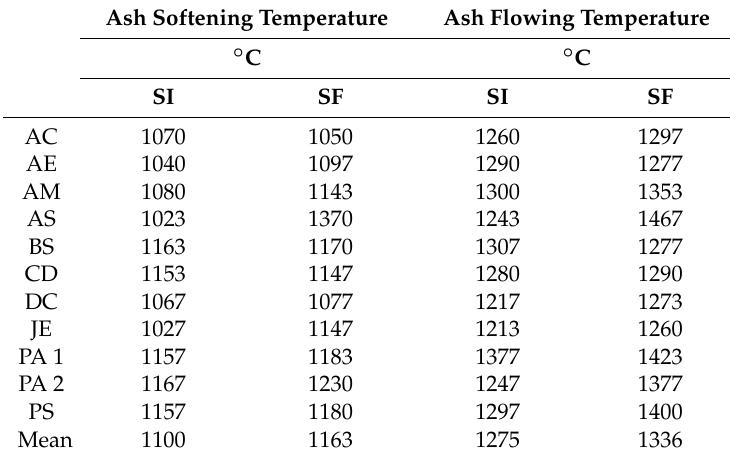
Table 4. Mean ash softening and flow temperature for silage (SI) and solid fuel (SF). Ash Softening Temperature Ash Flowing